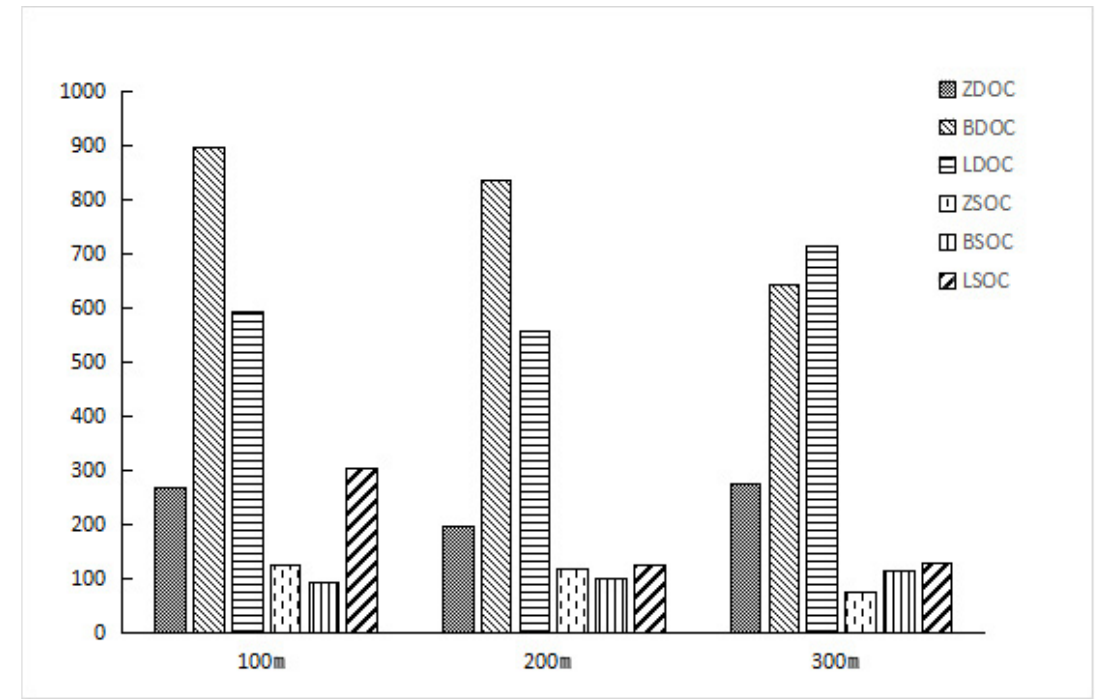
Figure 2. Distribution of the content of SOC and DOC in the upslope, mesoslope, and downslope (ZDOC—the content of DOC in pinus sylvestris var mongolica forest, BDOC—the content of DOC in birch forest, LDOC—the content of DOC in larch forest. ZSOC—the content of SOC in pinus sylvestris var mongolica forest, BSOC—the content of DOC in birch forest, LSOC—the content of DOC in larch forest).